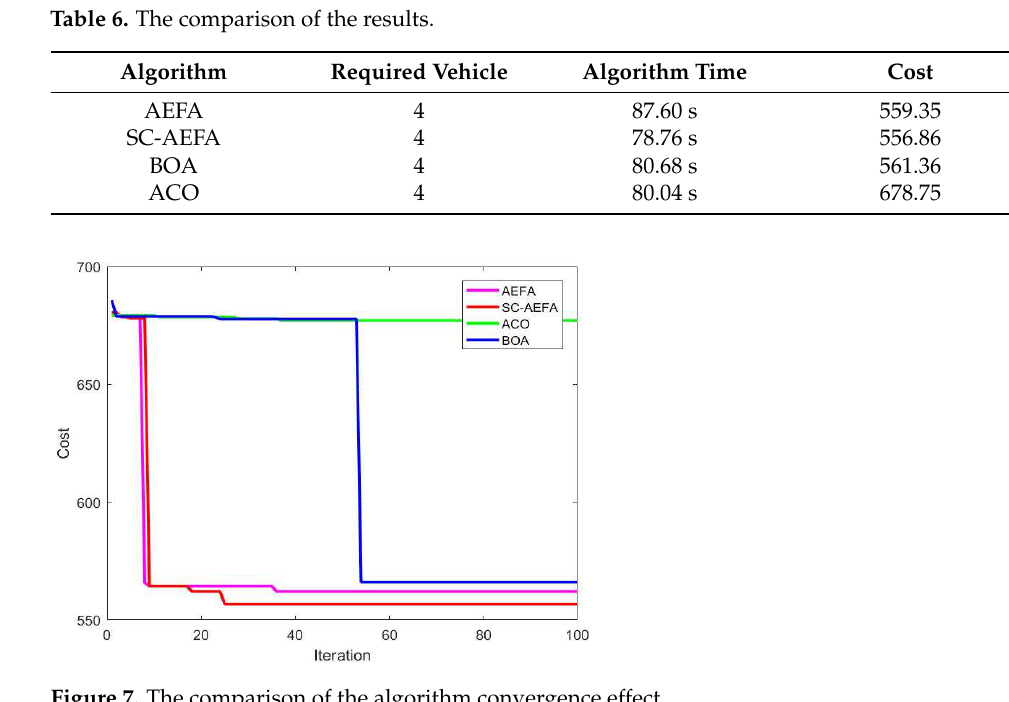
Figure 7. The comparison of the algorithm convergence effect.